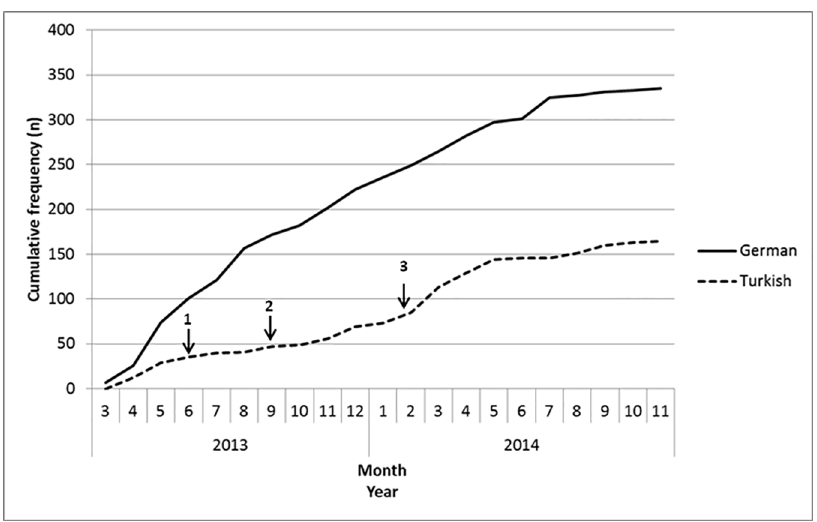
Fig 2. Cumulative frequency of German and Turkish consented participants over the recruitment period. Arrows and numbers indicateinitiationof actions taken to increase recruitment of Turkish patients (1 and 2: programme promotion in Turkish culture and health care institutions, 3: openingto other health care insurances).